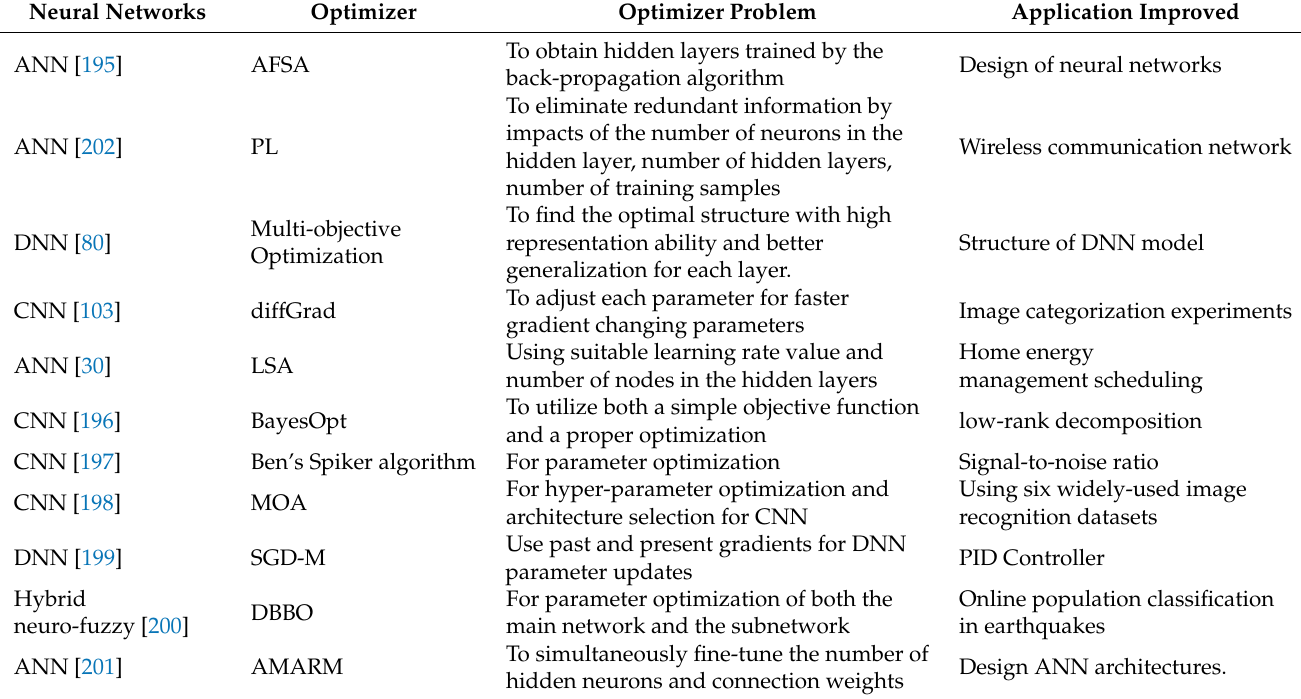
Table 10. Overview of various optimization-based neural network parameters (hidden layers, learning rate, neurons, and weights) optimization